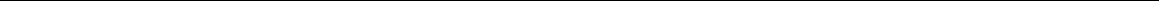
Table 1. A total of 58 malignant tumor cases were